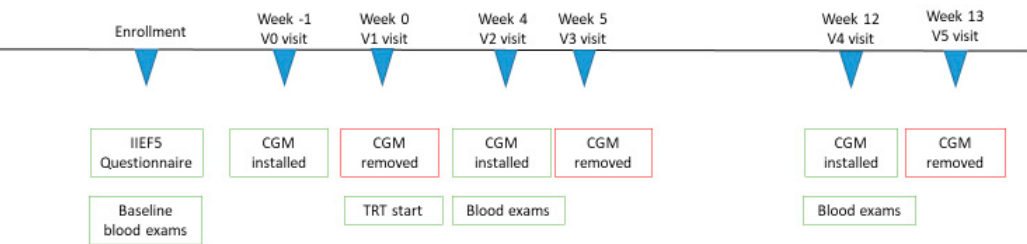
Figure 1. Study design. CGM Continuous Glucose Monitoring; IIEF5: international index erectile Function 5. TRT: Testosterone Replacement Therapy.